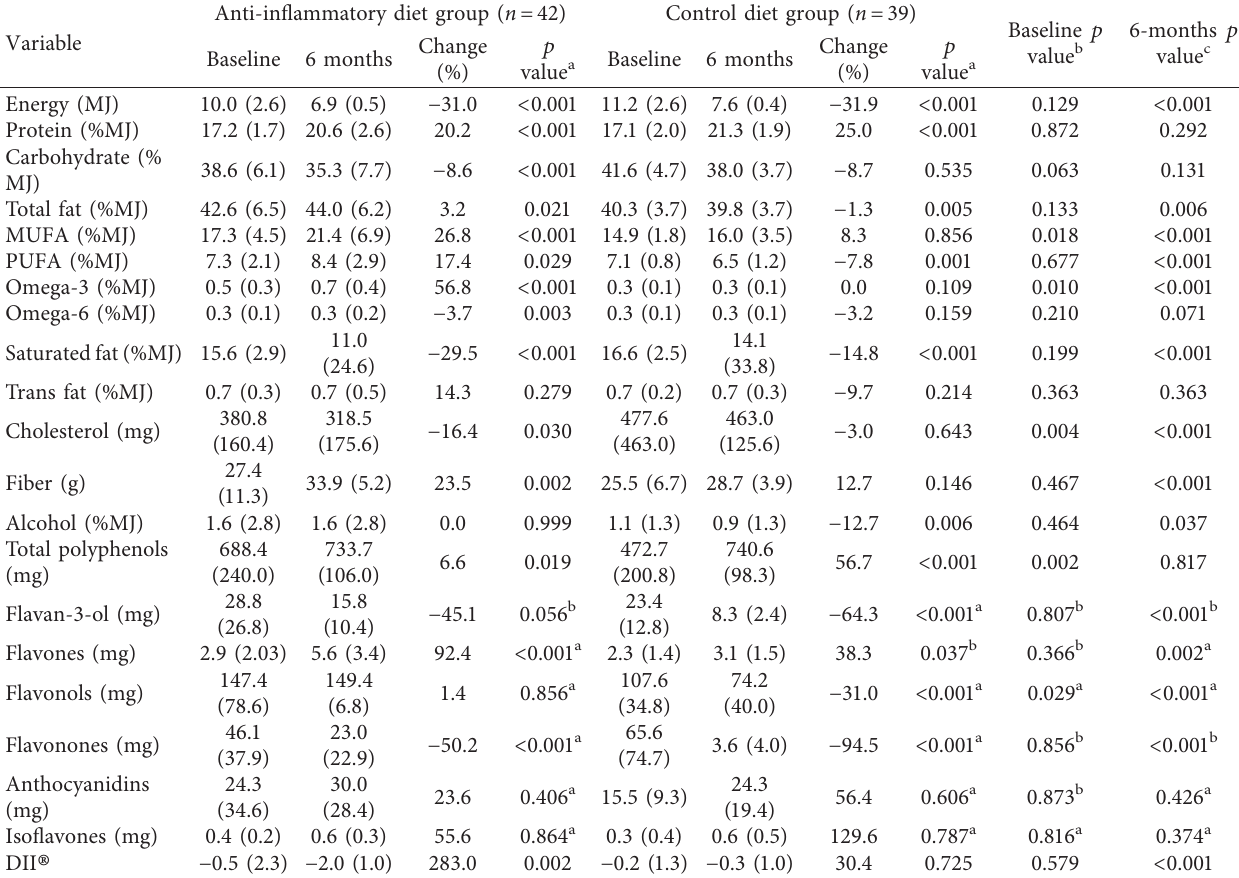
Table 3: Dietary intake at baseline and after 6months of dietary intervention.